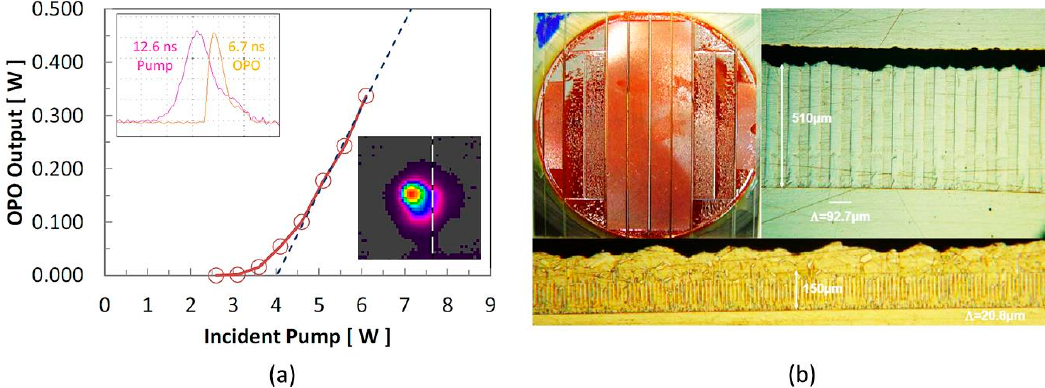
Figure 28. ( a ) Frequency conversion in OPGaP at 3.54 µm pump beam [49]; ( b ) Homoepitaxial growth of OPGaP on a 3-inch OPGaP template—at finer pattern periods the pattern is often overgrown [50]. (Reproduced from [49,50] with the permission of SPIE).